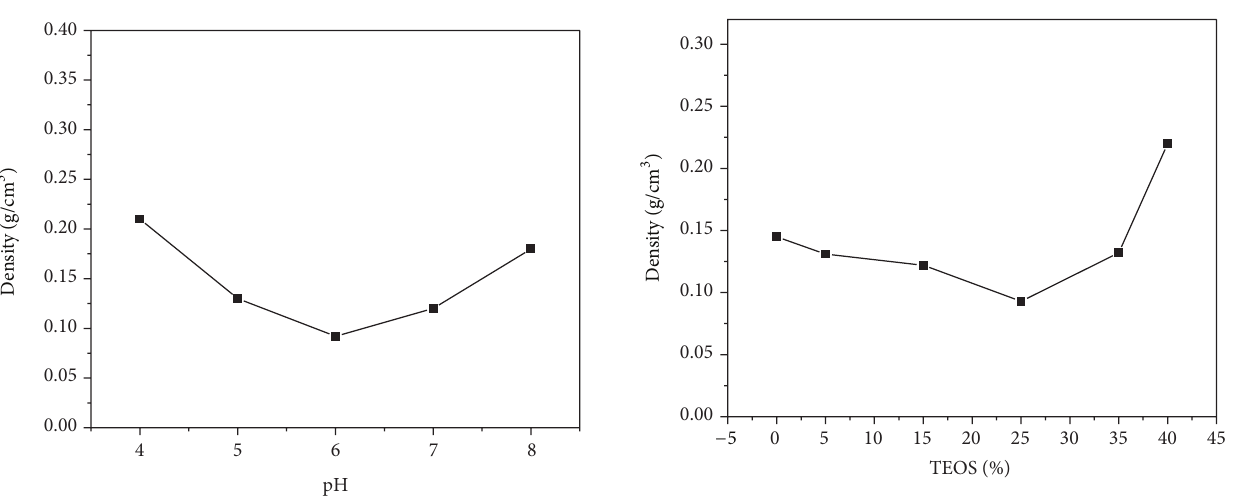
Figure 2: The relation of aerogel density to the pH value of the mixture.